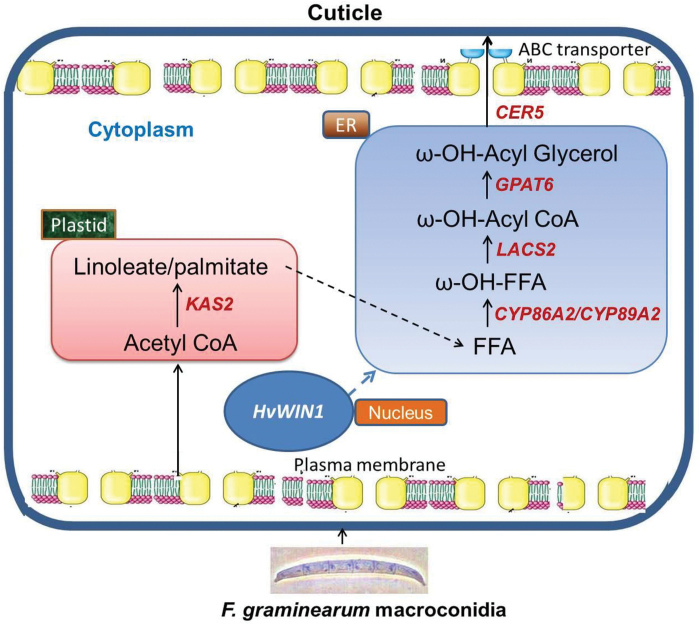
A proposed model showing HvWIN1 regulating genes involved in cuticle biosynthesis to resist the pathogen. Genes selected for expression studies are shown in bold italics. CER5, ABC transporter; CYP86A2, cytochrome P450 86A2; CYP89A2, cytochrome P450 89A2; GPAT6, glycerol-3-phosphate acyltransferase6; KAS2, β-ketoacyl-(acyl carrier protein) synthase II; LACS2, long-chain acyl-CoA synthetase. A colour version of this figure is available at JXB online.